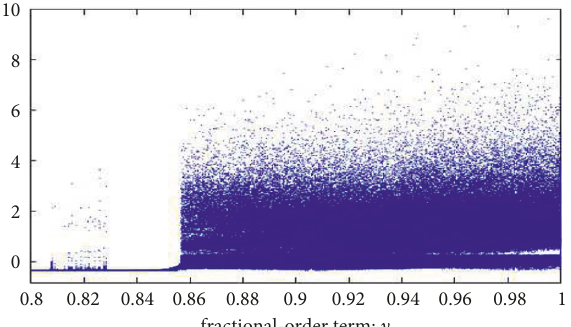
Figure 3: Bifurcation diagram of system (4) with respect to c